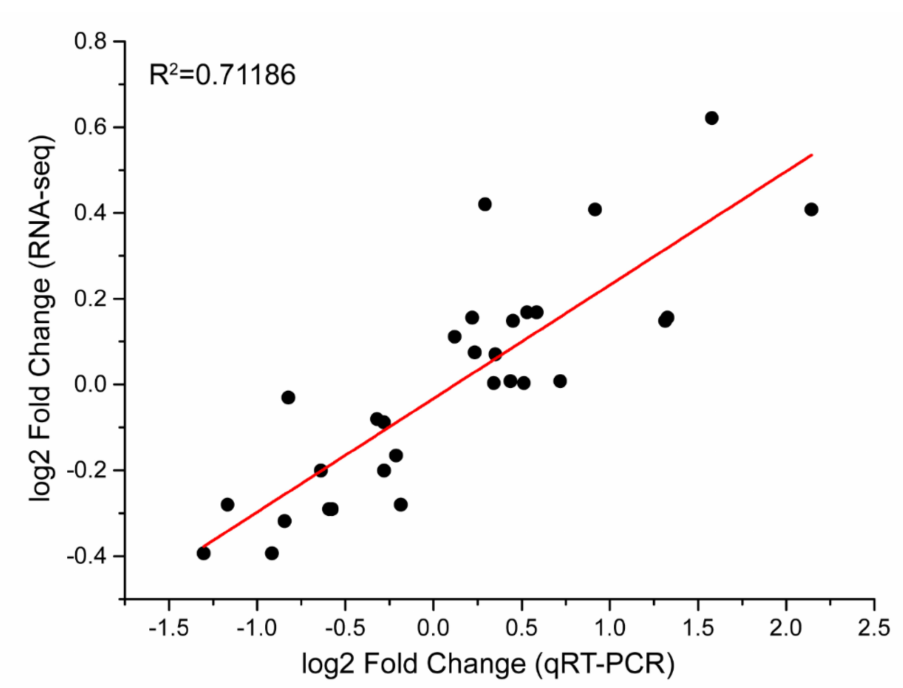
Figure 9. Correlation analysis of the selected genes based on qRT-PCR and RNA-seq data; Pearson’s correlation coefficient (R) was 0.84959 ( p < 0.05), R 2 =